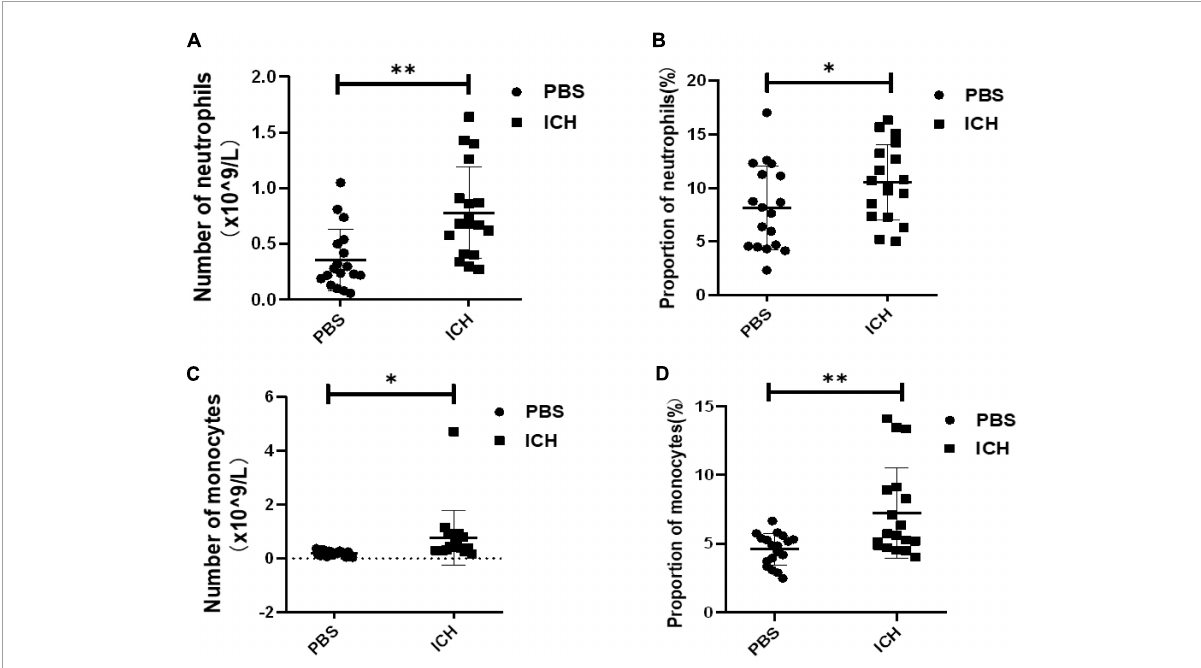
FIGURE2 ICH can induce changes in the number and proportion of inflammatory cells in peripheral blood. (A) Quantity of neutrophils in peripheral blood (** P < 0.01, n = 18 in each group); (B) neutrophils/peripheral blood ratio (* P < 0.05, n = 18 in each group); (C) quantity of peripheral blood mononuclear cells (* P < 0.05, n = 18 in each group); (D) ratio of mononuclear cells to peripheral blood (** P < 0.01, n = 18 in each